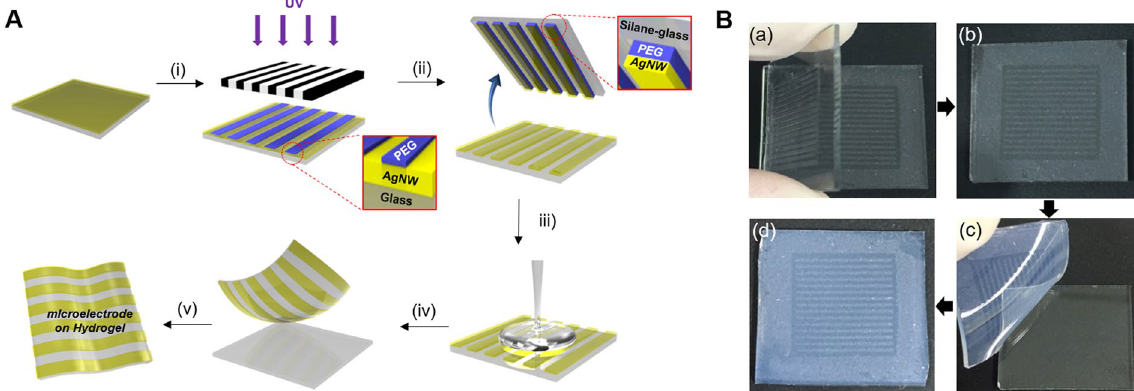
Figure 1. Fabrication of AgNW patterns on various substrates via two consecutive solution-only processes. ( A ) Schematic illustration for fabrication of AgNW-based micropatterns on the hydrogel: (i) AgNW dispersion solution was spin-coated on a glass substrate; (ii) PEG photolithography process using UV light via a photomask; (iii) peeling off of the PEG hydrogel layer by detaching the silane-treated cover glass to construct AgNW patterns on the glass substrate; (iv) second gel precursor solution (agarose or polyethylene glycol, or polyacrylamide) was poured onto the AgNW-patterned glass, and a second gelation process was conducted; and (v) peeling off of the second gel layer and transfer of the AgNW patterns from the glass to the hydrogel substrate. ( B ) Photographs showing the procedure used to fabricate AgNW-based micropatterns: (a) peeling off of the PEG hydrogel layer by detaching the silane-treated cover glass; (b) AgNW micropatterns on the glass substrate; (c) peeling off of the second gel layer; and (d) transfer of the AgNW patterns from the glass to the hydrogel